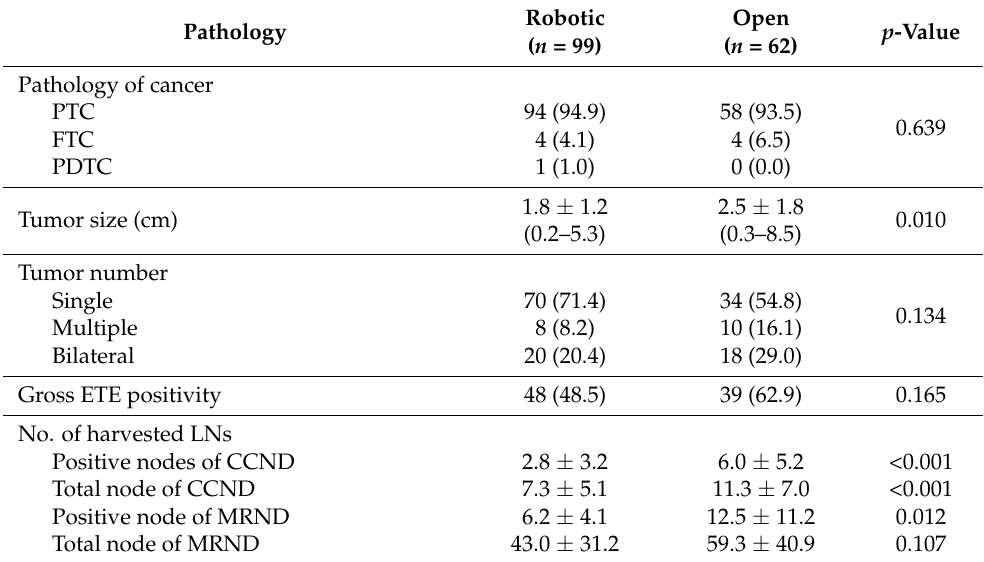
Table 3. Comparison of pathologic findings between patients treated with robotic and open thyroidectomy. Pathology